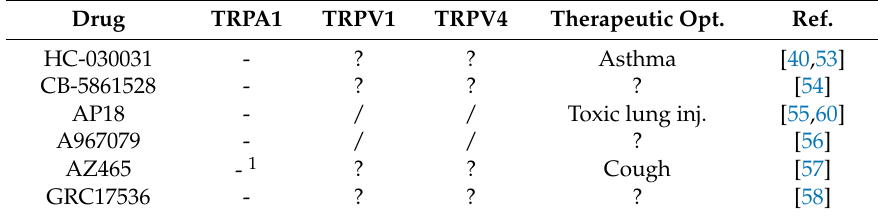
Table 2. Compounds inhibiting TRPA1 activity and prospective therapeutic options. Drug TRPA1 TRPV1 TRPV4 Therapeutic Opt. Ref.